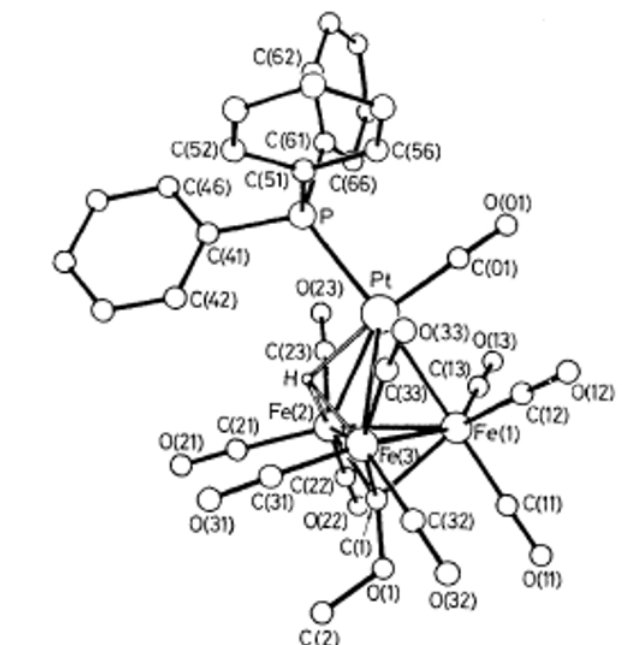
Figure 9. Structure of [(PPh